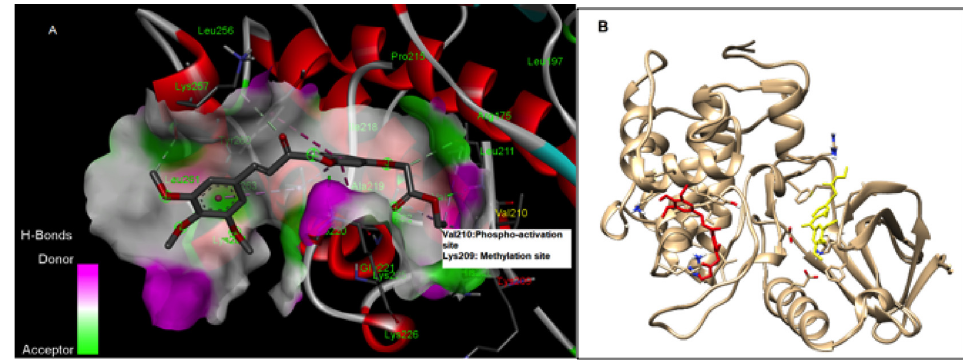
Figure 2. Binding interaction of the RK-10 compound. Using the computer-aided docking program Autodock 4.2, a model for binding of RK-10 with PLK1 (PDBID:3FC2) was created. The RK-10 compound binds to the allosteric site interacting with Lys-209 and Val-210. The Thr-210 residue in PLK1 is the “master switch” and a critical site residue, which becomes activated by phosphorylation, while methylation of Lys-209 by G9a prevents phosphorylation. In the crystal structure, the regulatory phosphorylation site, Thr-210, was mutated to Val-210 to reduce conformational heterogeneity. ( A ) Hydrogen binding interaction map of RK-10 with the Val-210 phospho-activation site, which is highlighted in yellow. ( B ) The docking model for the comparison of the binding mode of RK10 (red) with mutated Lys-209 Met (yellow). The mutation of Lys-209 to Met (a methyl-mimetic residue) inhibits the binding of RK-10 to the original site.